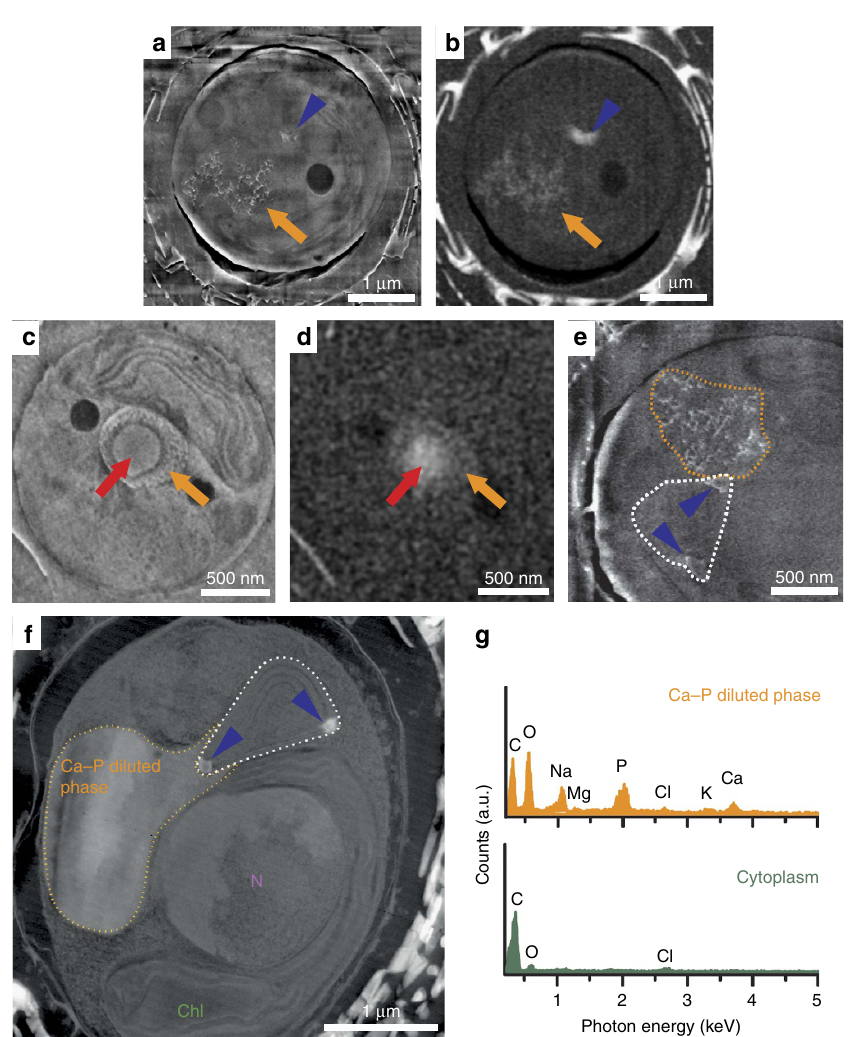
Figure 6 | Cells without Ca-rich body contained a compartment filled with diluted concentrations of calcium and phosphorus. ( a – e ) Slices from cryo-FIB-SEM image series of high-pressure frozen E. huxleyi cells imaged in secondary electron mode ( a , c , e ) and backscattered electron mode ( b , d ), showing coccolith calcite (blue arrowhead), the dense Ca–P-rich body (red arrow) and a pool of diluted concentrations of Ca (orange arrow, framed orange in e ) in close contact. The white line in e frames the coccolith vesicle–reticular body system. ( f ) HAADF-STEM image of a thin-sectioned cell showing the nucleus (N), the chloroplast (Chl), coccolith calcite (blue arrowhead), the coccolith vesicle–reticular body system (framed white) and the vacuole-like compartment containing Ca and P (framed orange). ( g ) EDX spectra taken from inside the compartment framed orange in f and of cytosol. The epoxy resin contributes to the C peak and therefore the C signal does not represent in vivo